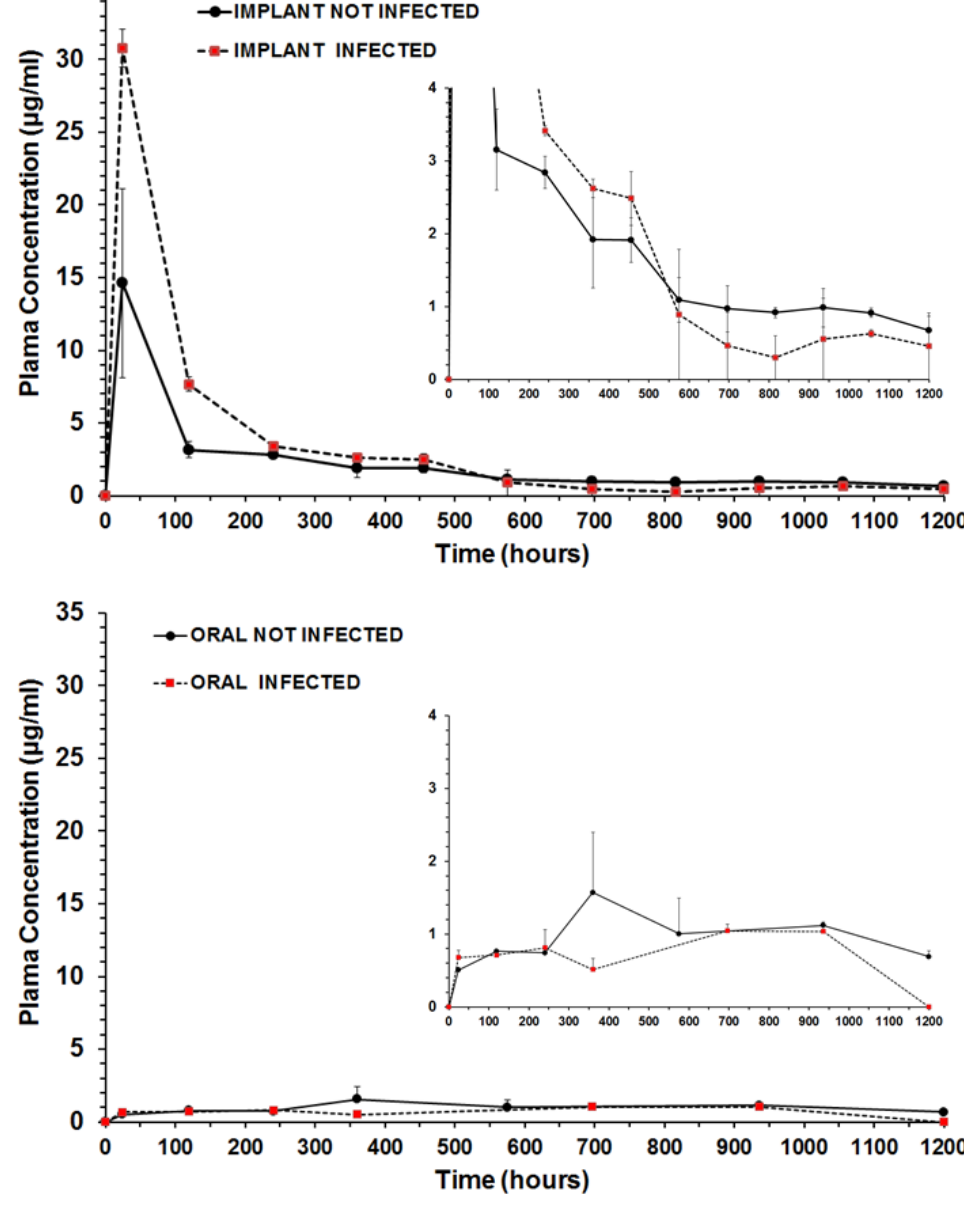
Figure 7. Benznidazole plasma concentration–time profiles upon administration of BZ–PCL implants (upper graph) and crushed tablet coarse suspension administered by gavage (lower graph), in healthy and T. cruzi -infected mice. Bars are standard deviations (n = 3 per group). Pharmacokinetic parameters were calculated and are shown in Table 4.